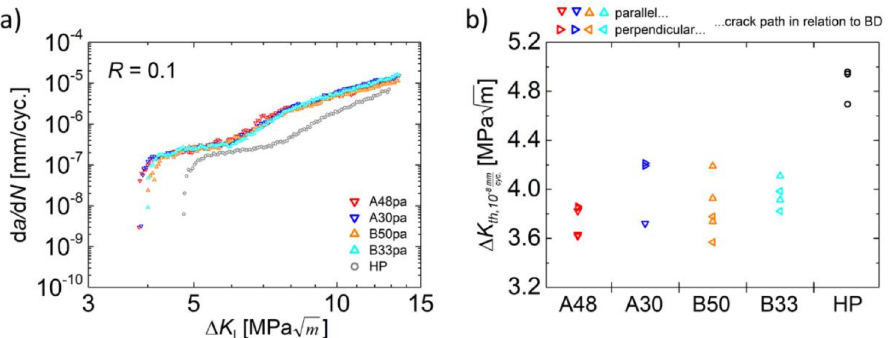
Figure 4. Comparison of the crack growth curves ( a ) and threshold values ∆ K th ,10 − 8 mm/cyc. ( b ) for the individual material